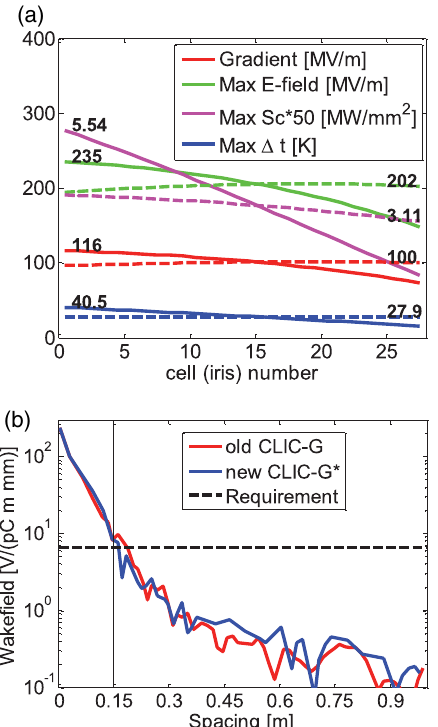
FIG. 17. (a) Distribution of rf parameters (red: accelerating gradient; blue: pulse temperature rise; green: maximum surface electrical field; magenta: maximum modified pointing vector [30]; dashed lines for unloaded 100 MV = m and solid lines for loaded 100 MV = m) along the CLIC-G (cid:2) structure cells. (b) Sim- ulation results of transverse wakefield in the old baseline CLIC-G and new CLIC-G (cid:2) structures (enveloped